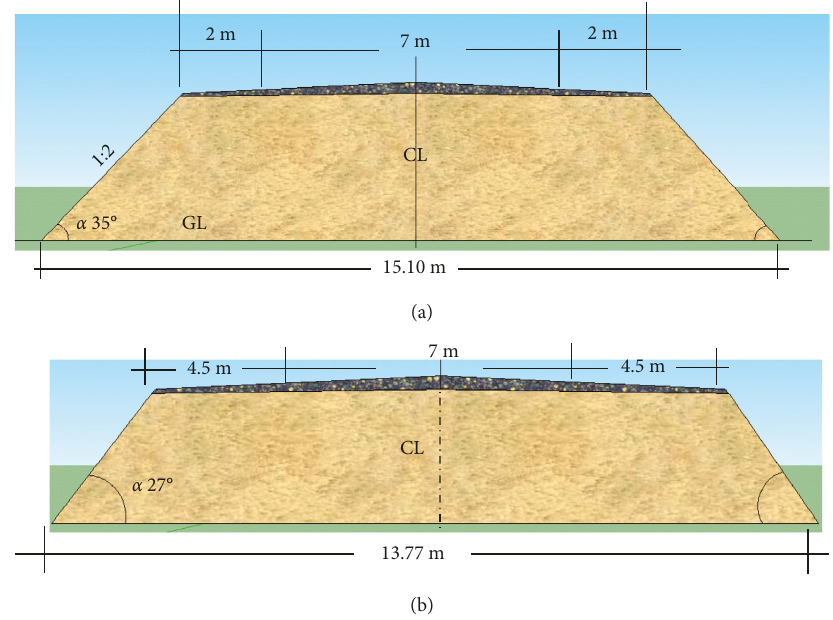
Figure 1: Cross sections of the Wad Medani-Sennar road.